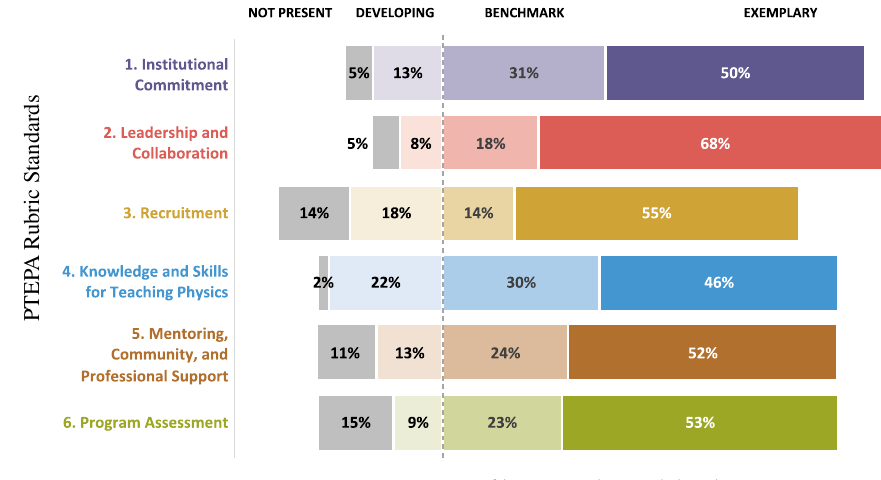
FIG. 2. Percent of items rated at each level across all eight studied programs, by standard. From the left are shown not present (gray), developing (light shaded), benchmark (medium shaded), and exemplary (dark shaded). Percentages are out of the number of available ratings per standard (No. of items/standard × 8